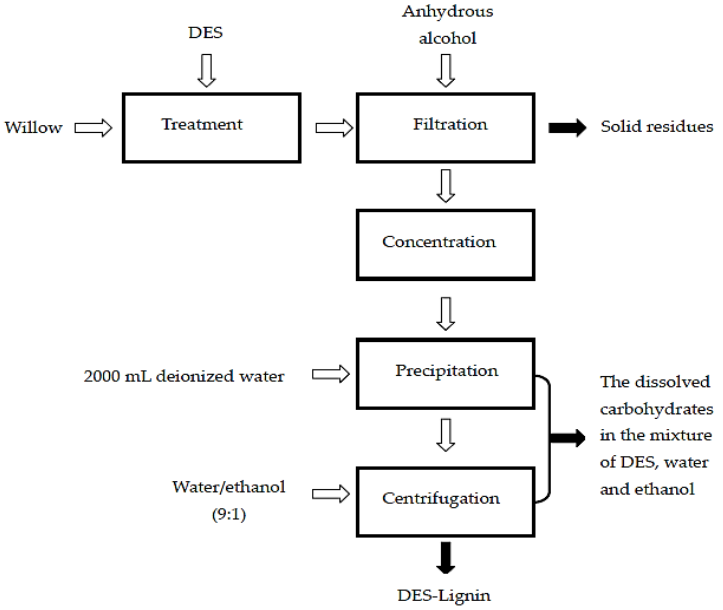
Figure 7. Flow diagram of willow treatment with DESs.